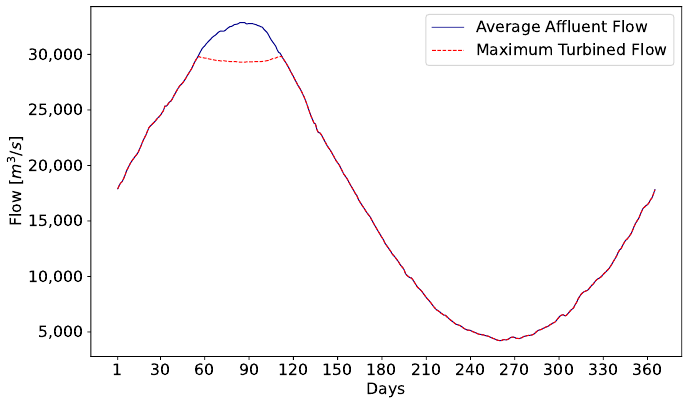
Figure 6. Average Affluent Flow and Max Turbined Flow.